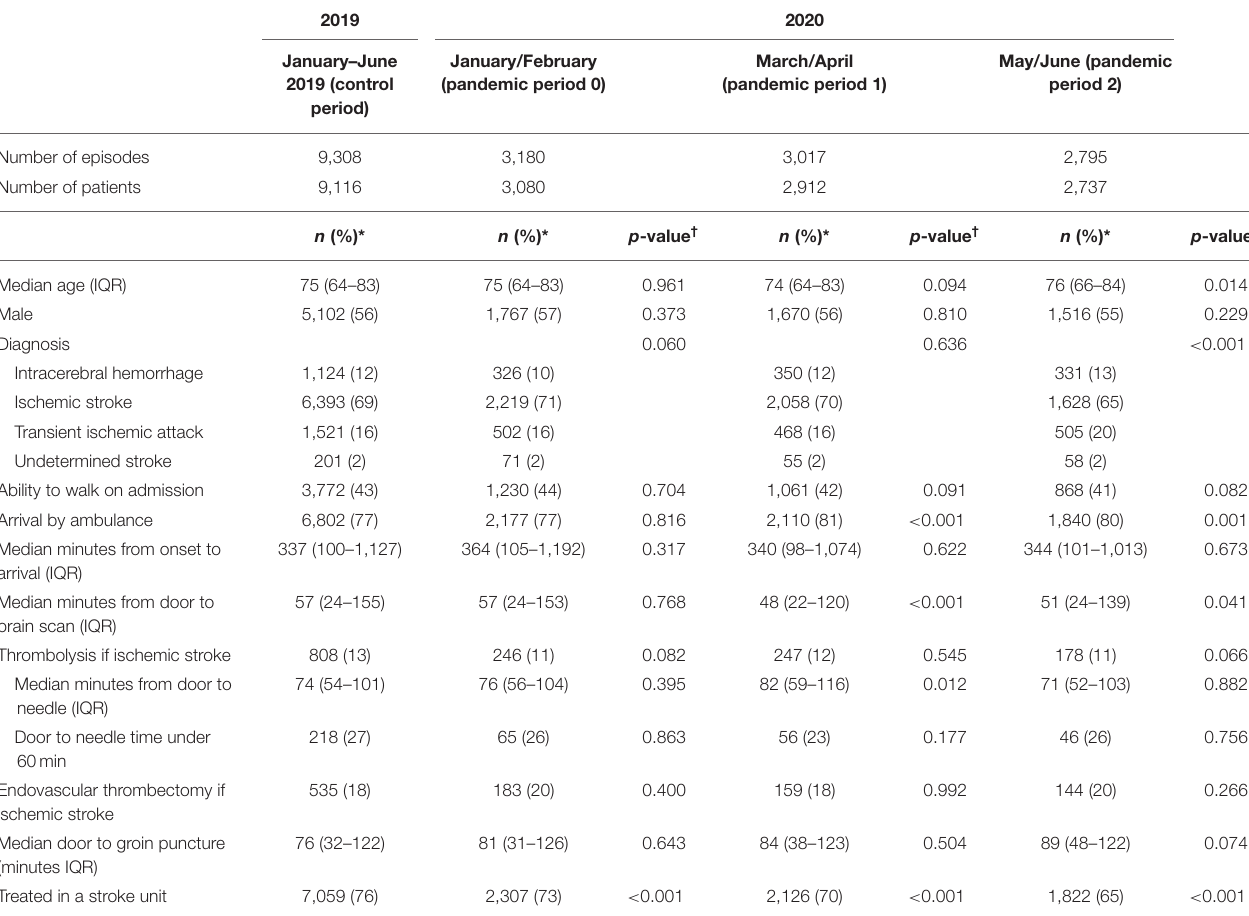
TABLE 1 | Comparison of patient characteristics and clinical care for the historical-control period and different stages of the pandemic in